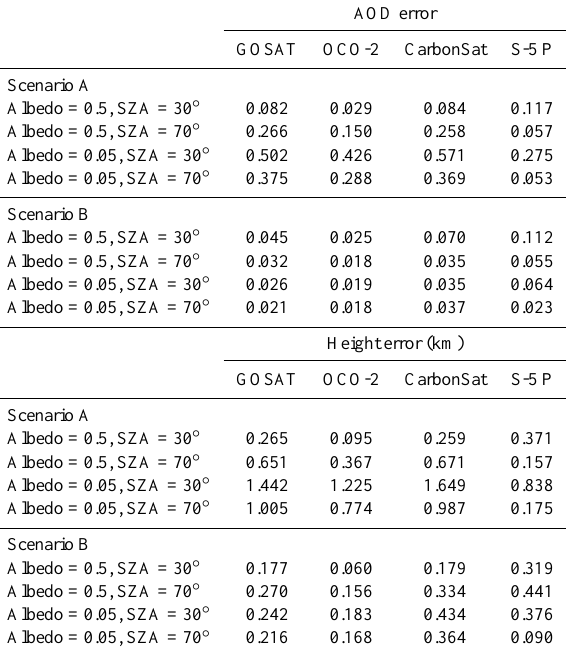
Table 3. Errors of retrieved AOD (top) and height (bottom) for the parameterized aerosol retrieval for aerosol scenarios A and B. In- tensity offset is